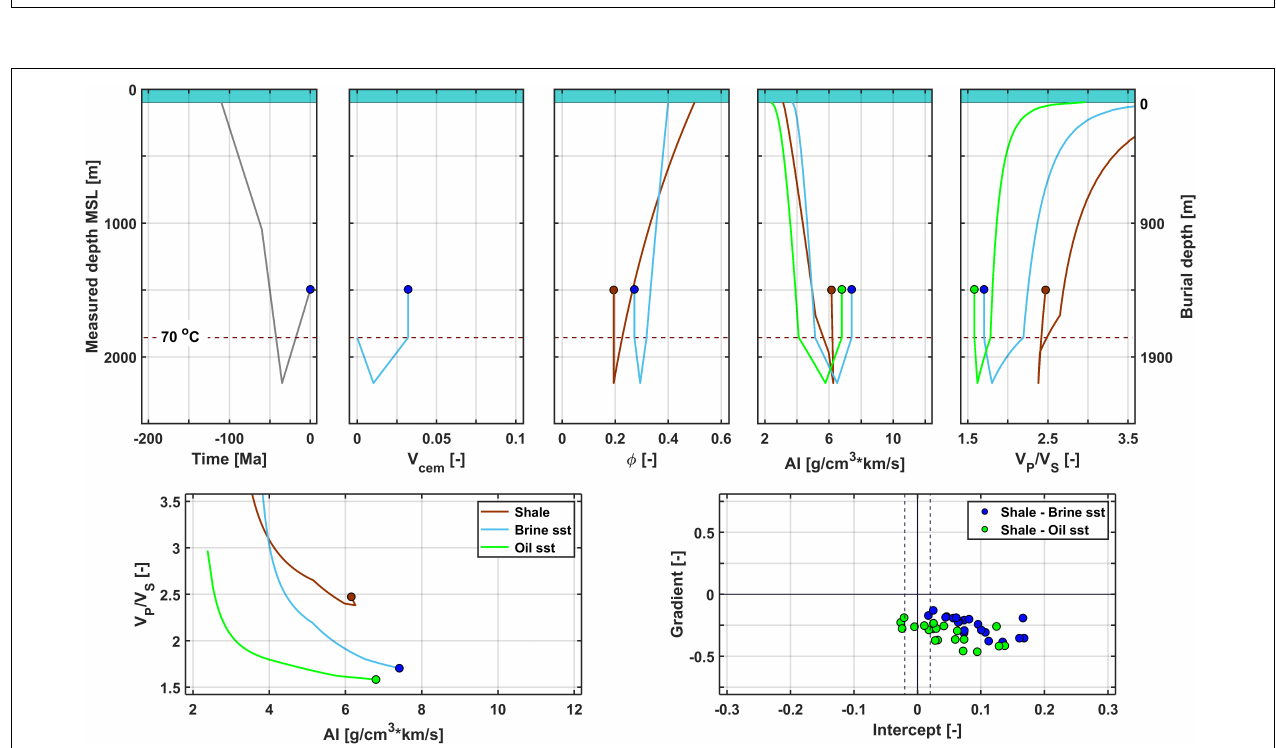
FIGURE 4 | Combined burial and rock physics modeling for a Cretaceous sandstone with Cenozoic tectonic uplift. Note the drastic change in rock physics, and seismic properties as the burial goes from mechanical to chemical compaction domain ( > ca. 70 ◦ C indicated by the dashed horizontal line).